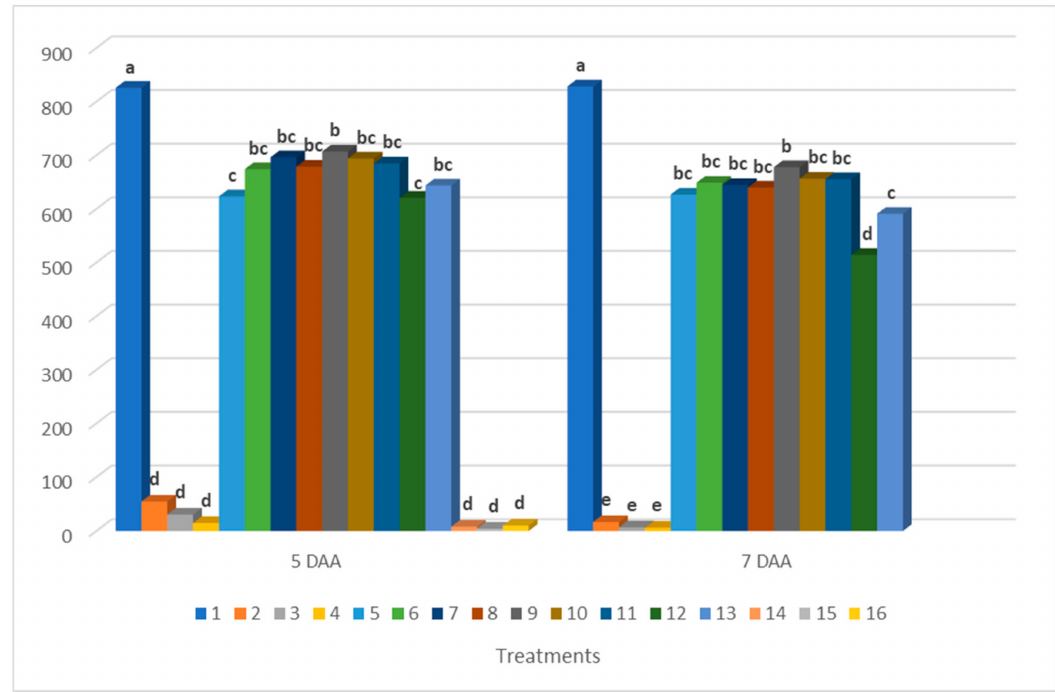
Figure 3. The effect of herbicides on Fv—variable fluorescence (non-nominated units). a–e different letters indicate statistically different mean LSD ( p < 0.05) 5 DAA = 52.06; LSD ( p < 0.05) 7 DAA = 50.94. (1—untreated; 2—16 herbicides applied at different pH of the spray solution: 2–4—mesotrione; 5–7—nicosulfuron; 8–10—rimsulfuron; 11–13—mesotrione + nicosulfuron + rimsulfuron + adjuvant; 14–16 bromoxynil; details description of treatments is included in Table